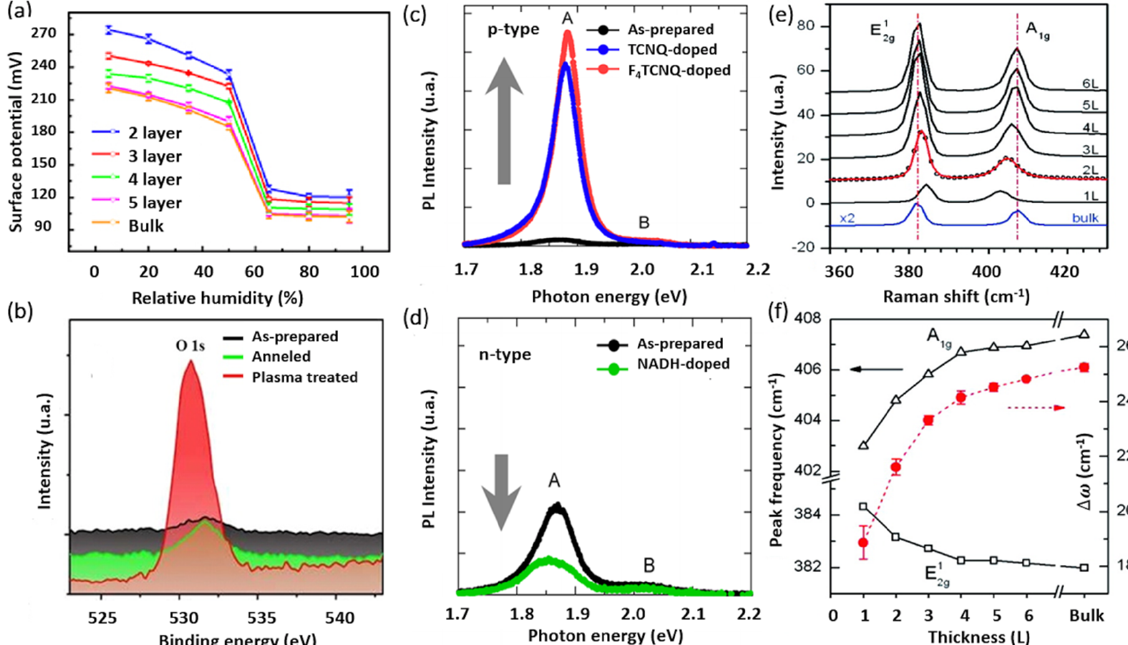
Figure 5. ( a ) Surface potential captured by KPFM vs. relative humidity RHs with respect of the number of MoS 2 layers (reproduced and adapted from Ref. [133], Copyright 2017, IOP Publishing); ( b ) XPS spectra of Mo 3d and S 2s core levels for different treatment conditions (adapted from Ref. [132] Copyright 2014, American Chemical Society); ( c , d ) PL spectra of monolayer MoS 2 before and after being doped (reproduced from Ref. [134] Copyright 2013, American Chemical Society); and ( e , f ) Raman spectra for various MoS 2 films with respect to the number of MoS 2 layers (reproduced from Ref. [135] Copyright 2010, American Chemical Society).